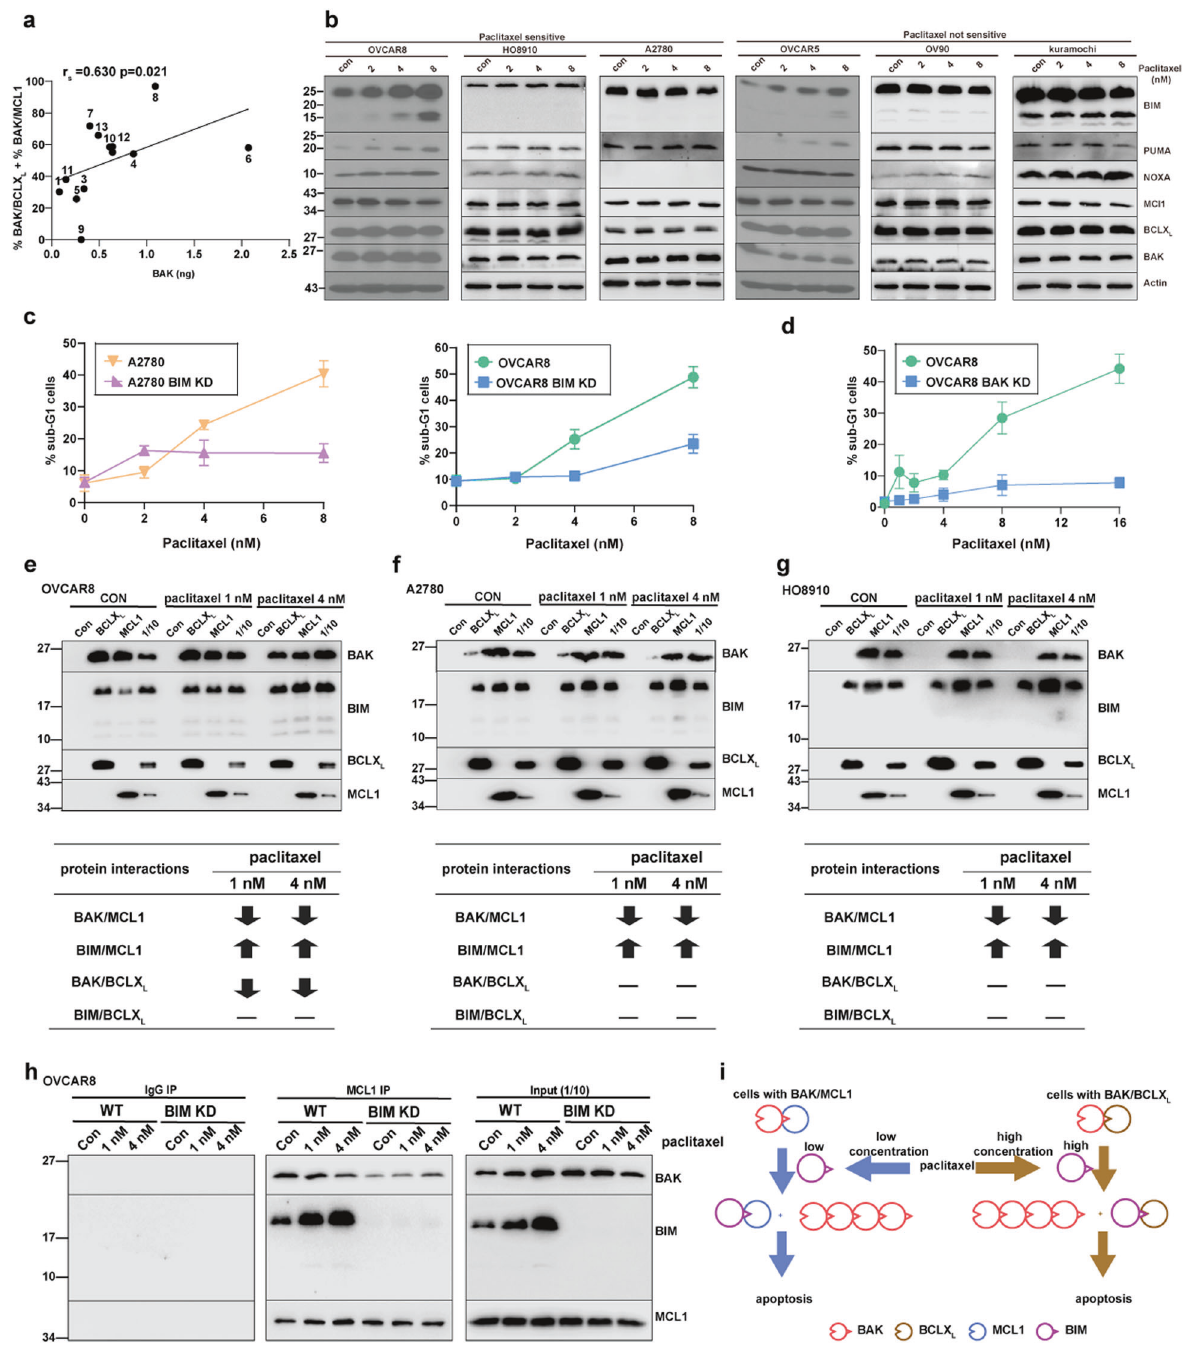
Fig. 5 BIM induced by low-dose paclitaxel binds MCL1 and disrupts the BAK/MCL1 complexes. a Spearman correlation analysis between protein levels (ng/10 5 cells) of BAK and %BAK/BCLX L + %BAK/MCL1. b After paclitaxel sensitive (OVCAR8, HO8910, A2780) and paclitaxel insensitive cells (OVCAR5, OV90, Kuramochi) were treated with the indicated concentrations of paclitaxel, whole-cell lysates were blotted for indicated proteins. c , d A2780 (left panel of c ), or OVCAR8 (right panel of c , and d ) cells were transfected with indicated siRNA to induce protein knockdown (KD). After 24 h, cells were treated with the indicated concentrations of paclitaxel for 48 h, the percentages of sub-G1 cells were detected by fl ow cytometry. ( n = 3 independent experiments, mean ± S.D.) e – g After OVCAR8 ( e ), HO8910 ( f ), or A2780 ( g ) cells were treated with the indicated concentrations of paclitaxel in the presence of Q-VD-OPh for 48 h, CHAPS lysates were immunoprecipitated with rabbit IgG (CON), or antibodies to BCLX L or MCL1. The immunoprecipitated proteins together with the indicated amount of input (1/10 or 1/4) were blotted with the indicated antibodies (upper panels) and analyzed (bottom panels). h After OVCAR8 were transfected with BIM siRNA (BIM KD) for 24 h, cells were then treated with the indicated concentrations of paclitaxel in the presence of Q-VD-OPh for 48 h. CHAPS lysates were then prepared for immunoprecipitation with rabbit IgG (CON) or antibodies to MCL1. The immunoprecipitated proteins together with indicated one-tenth of input were blotted with the indicated antibodies. i Proposed model to explain why cells with BAK/MCL1 complexes were more sensitive to